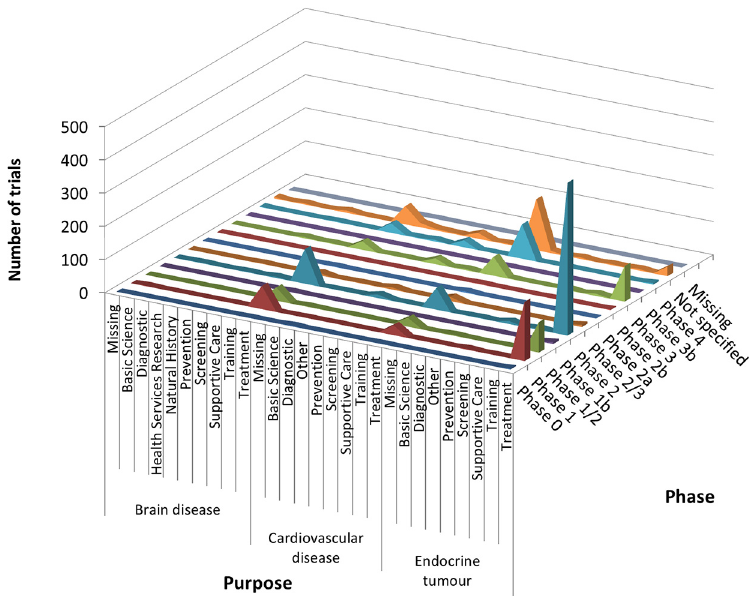
Fig 1. Cross-analyses between trial purpose and phase in ClinicalTrials.gov. Curve areas represent the number of trials across the phase and the trial purposes, for brain diseases, cardiovascular disease, and endocrine tumors, respectively.